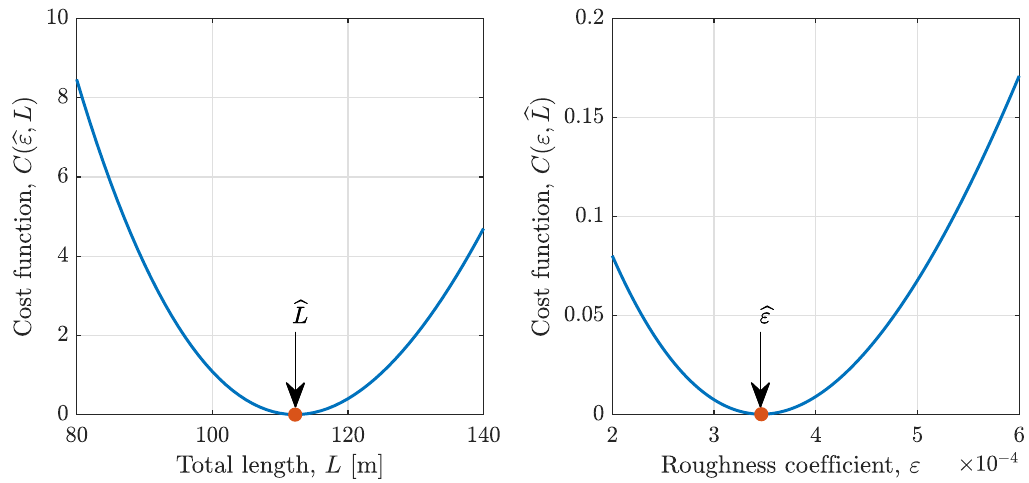
Figure 6. Behavior of the cost function in the neighborhood of the optimal estimate.